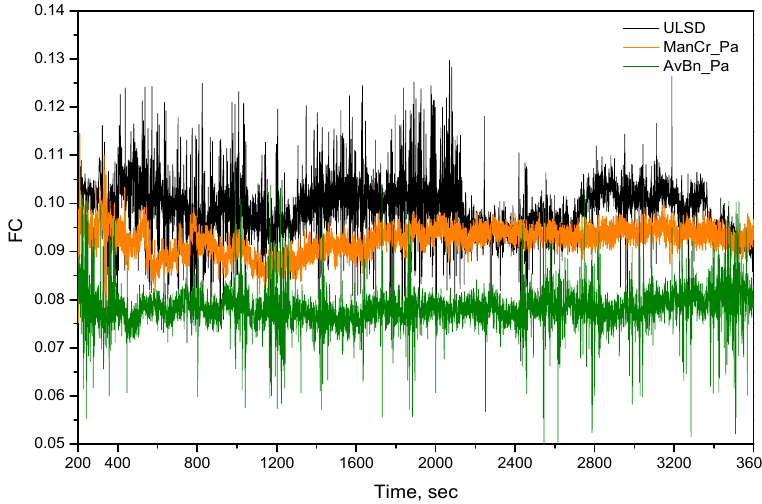
Figure 3. Variation of FC with time at steady state condition for ultra-low-sulphur diesel (ULSD), ManCr_Pa and AvBn_Pa.